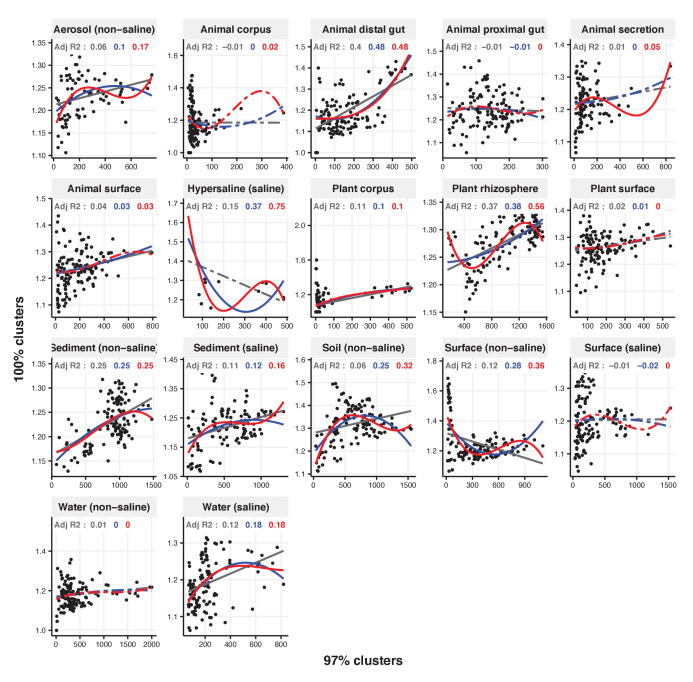
Focal clusters at 97% nucleotide identity.Community diversity was estimated as the number of clusters at a focal level (di) and focal lineage diversity as the mean of the clusters at the rank above (di 1/di). Linear (grey), quadratic (blue) and cubic (red), with corresponding adjusted R-squared values in the same colour. P-values are Bonferroni corrected for 17 tests. Significant, p<0.05 (solid lines), non-significant (dashed lines). The x-axis shows the number of clusters at the focal percent-identity level (di), and the y-axis is the mean of the clusters at the rank above (di 1/di).